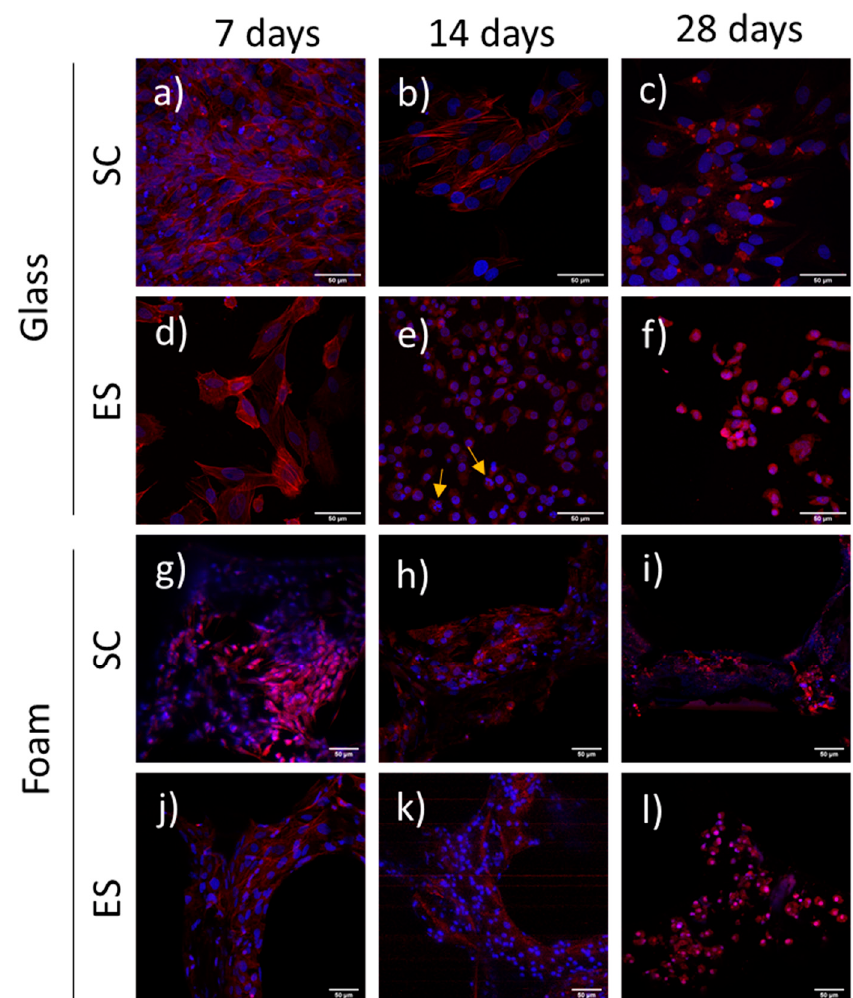
Figure 4. Actin distribution in human Saos-2 cells cultured for 7, 14 and 28 days under standard conditions (SC) or electrical stimulation (ES) on either glass coverslips ( a – f ) or Pd-coated PU foams ( g – l ). Stress fibers (red) and nuclei (blue) can be observed. Yellow arrows point to apoptotic nuclei. Pd-coated PU foams images ( g – l ) were obtained at less augmentation and digitally augmented due to the nature of the foam material.